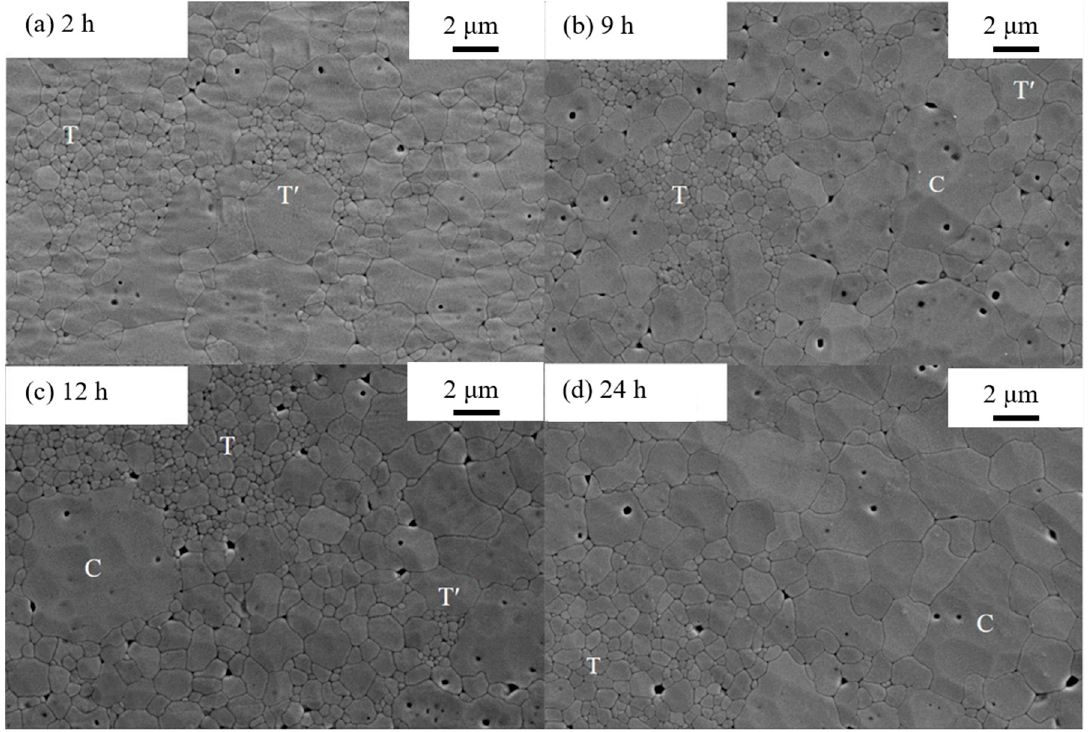
Figure 2. SEM images of 8YSZ morphology with periods of annealing time ( a ) 2 h, ( b ) 9 h, ( c ) 12 h, ( d ) 24 h.